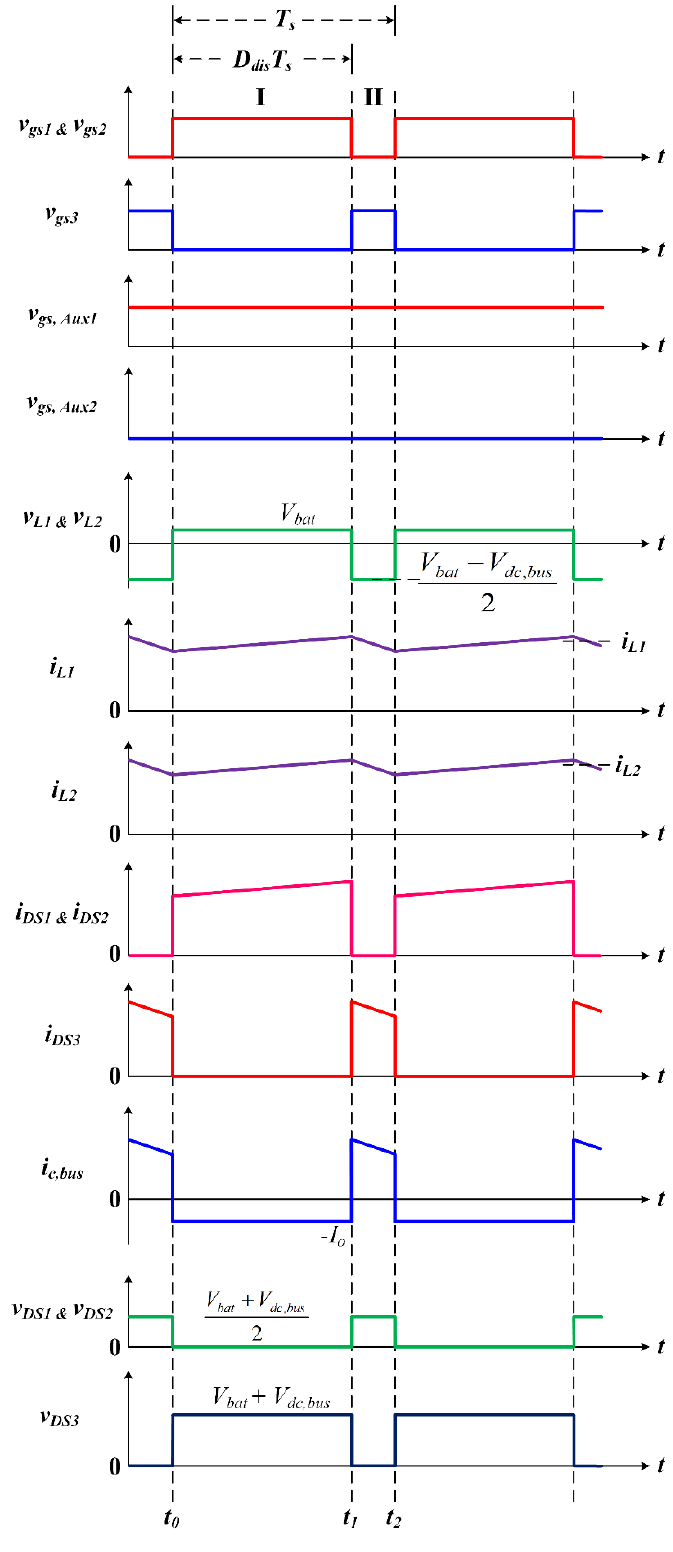
Figure 3. The waveforms of the step-up mode.